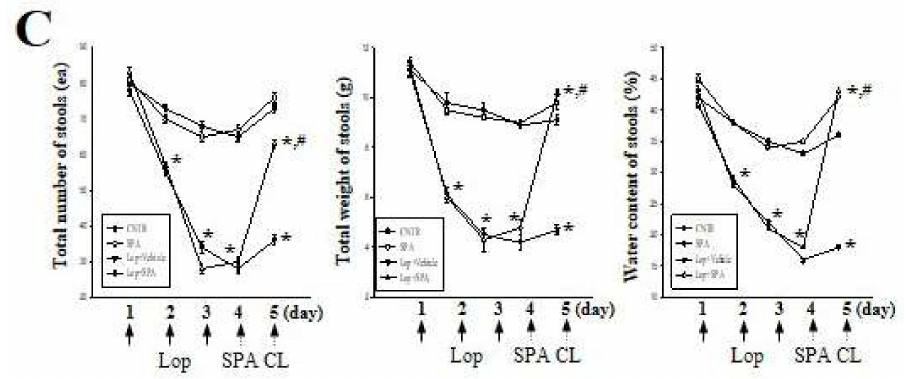
Figure 1. The number, weight, and water content of the stools of Lop-induced constipated SD rats after SPA administration. ( A ) The digital camera images of the stools were taken immediately after collection from the metabolic cage. Scale bar was represented 3 cm. ( B ) At 5 days, the total number and weight of stools were measured as described in the materials and methods. The stool water content was calculated using the weight of fresh stools and the dried weight. ( C ) From the 1st day to the 5th day, the total number, weight, and water content of stools was measured as described in the materials and methods. Six to seven rats per group were used in the stools’ collection, and each parameter was assayed in triplicate. The data are reported as the mean ± SD. * p < 0.05 compared to the CNTR group. # p < 0.05 compared to the Lop + Vehicle-treated group. CL, final